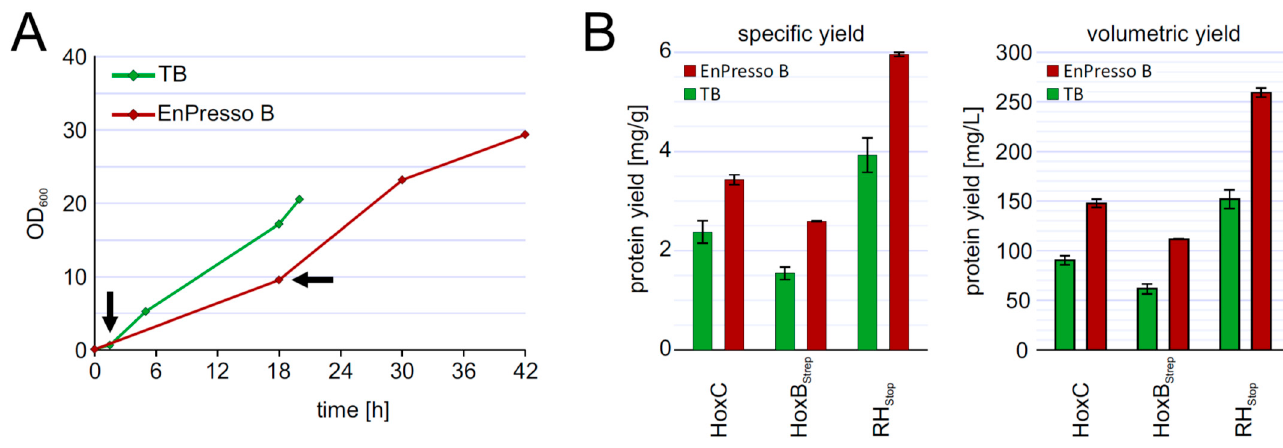
Figure 6. Up-scaling of RH production to 500 mL culture volume in 2.5 L UYF ( A ) growth curve of strain BQF8RH in complex TB or boosted EnPresso. ( B ) Calculation of specific and volumetric RH yield from strain BQF8RH as grown in A .